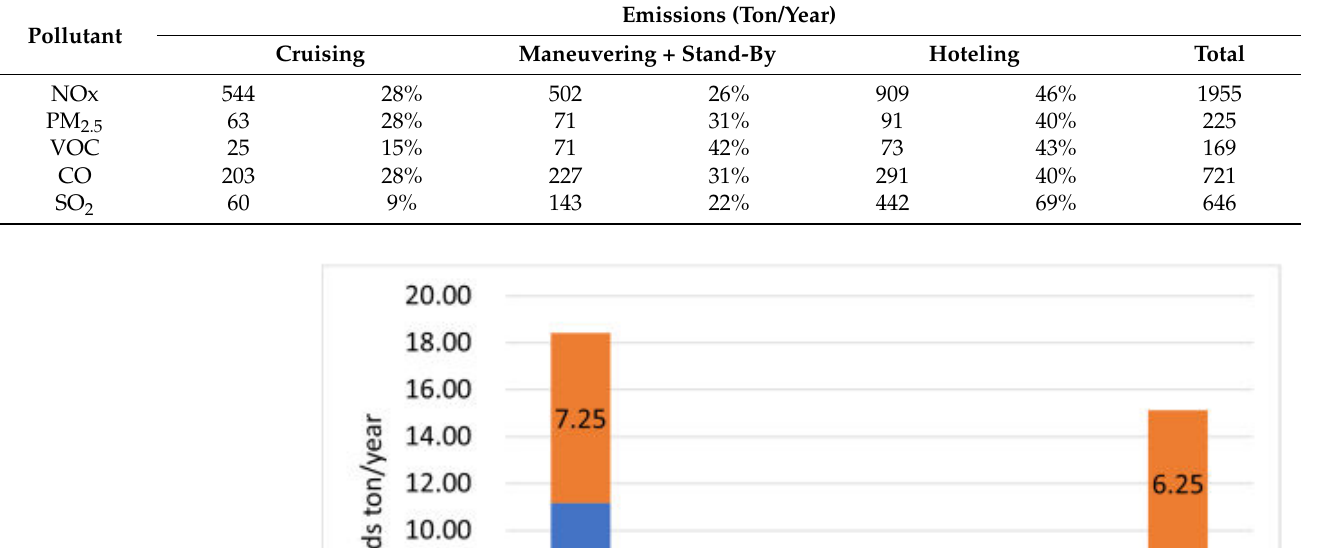
Table A26. Total emissions from vessels (Ashdod, MPS 2030).